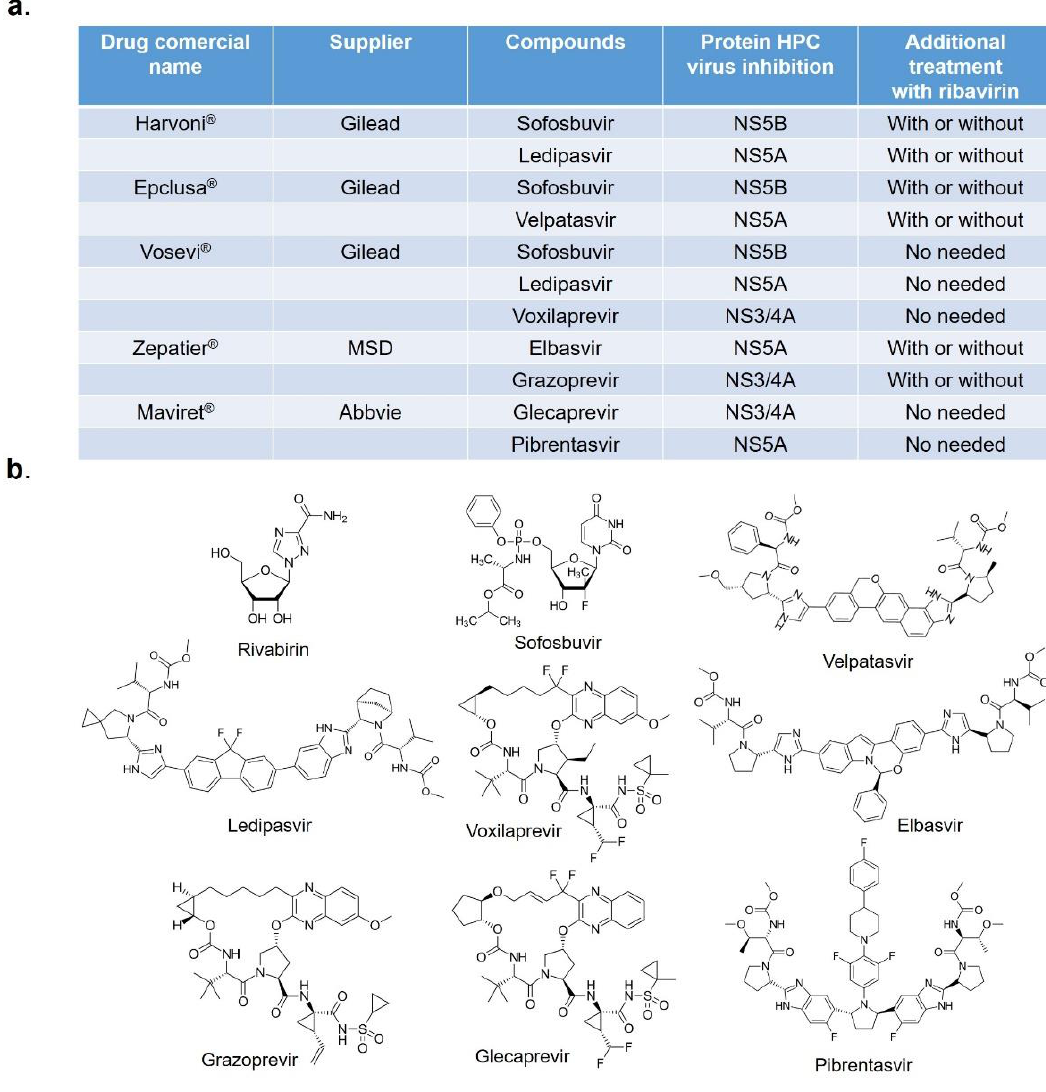
Figure 1. Currently marketed drugs against hepatitis C virus. ( a ) Pharmacological preparations. ( b ) Chemical structures of active molecules.